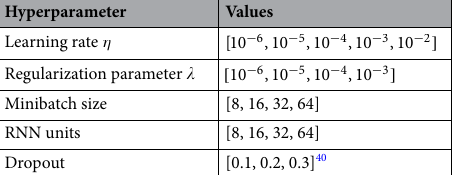
Table 3. List of hyperparameters tested in LSTM network